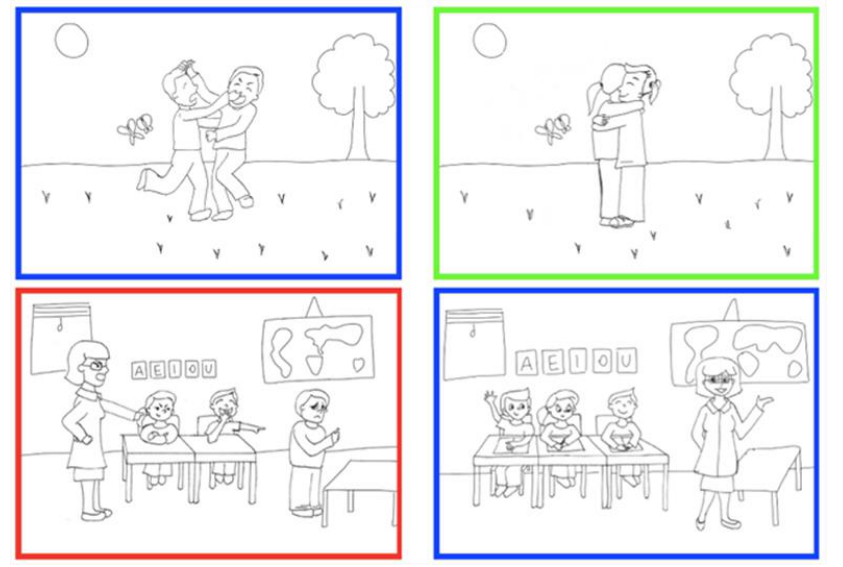
Figure 1. Examples of Positive and Negative, Indoor and Outdoor Matched Stimuli from the Emo- tional Stroop Task.